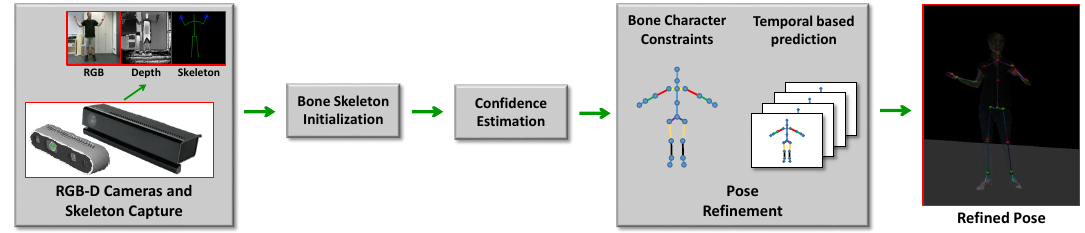
Figure 3. An overview of the proposed pose estimation pipeline given initial possibly corrupted estimations of the skeleton joint positions provided per frame by the pose estimation software for depth cameras, such as the Kinect SDK v2 or the SDK for Intel RealSense D435: Our framework performs a refinement based on symmetry constraints between the left and right body parts as well as the constraint for constant lengths of skeletal parts. Furthermore, outliers detected within the initial joint location estimates are counteracted by additional joint location estimates predicted based on temporal